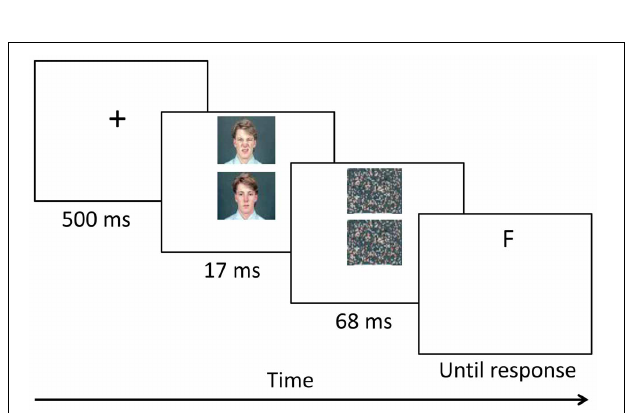
consisted of face photographs of 16 different actors (8 females) taken from the NimStim stimulus set (Tottenham et al.,